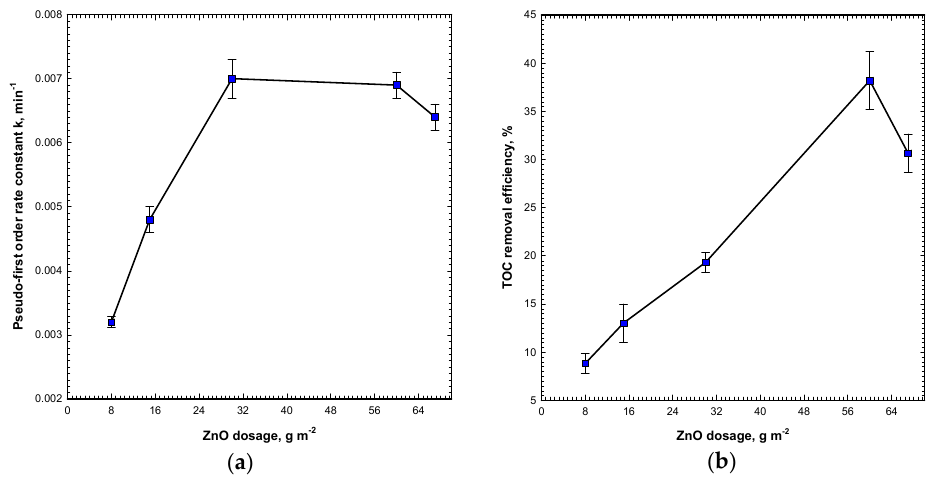
Figure 3. Effect of ZnO dosage on ( a ) the pseudo-first-order rate constant and ( b ) the TOC removal efficiency by the Vis/ZnO process. The operating conditions were same as in Figure 3.